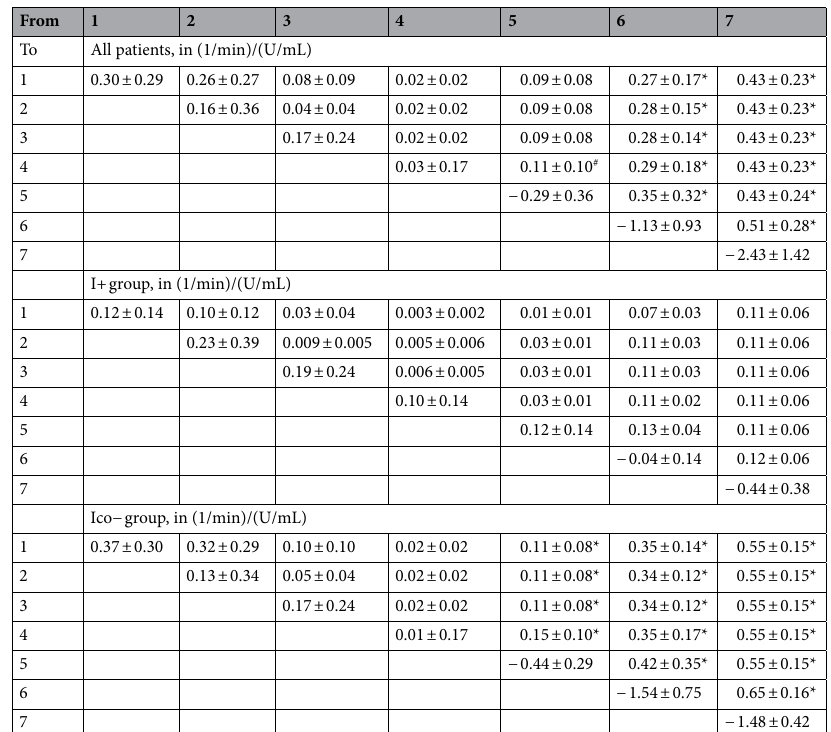
j i (in (1/min)/(U/mL) describing rate constants at